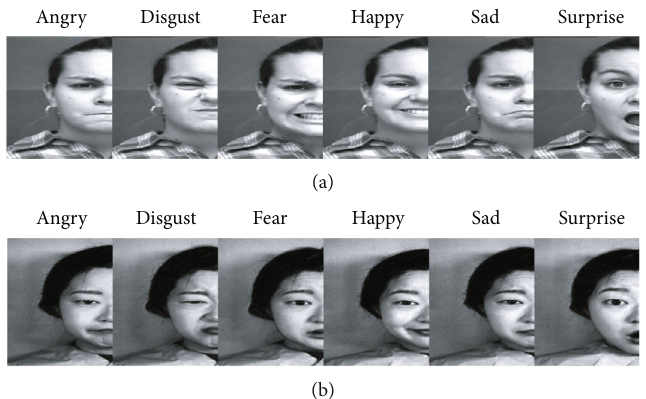
Figure 2: Sample of left half-face images under varying expressions (test-image database 1): (a) left half-face image under varying expressions from the CKFE database; (b) left half-face image under varying expressions from the JAFFE